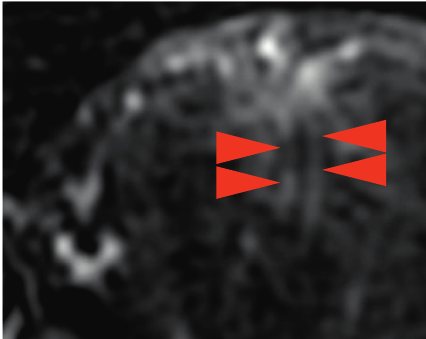
Figure 2: Pelvic MRI of endometrial stromal sarcoma: in DCE-MRI, angiogram depicted tumor regions containing dense wide, regular, and parallel vessels (arrowheads).